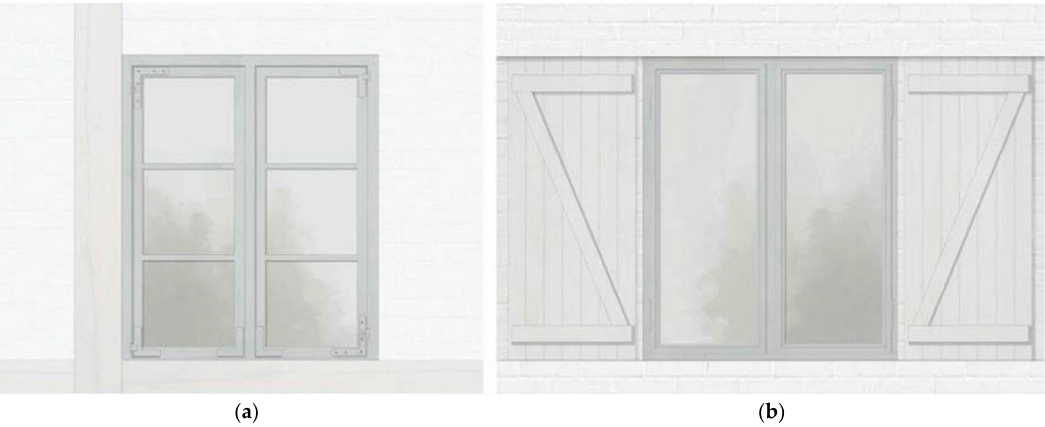
Figure 12. Juxtaposition of new windows in the restored wings ( a ) and in the reconstructed wings ( b ).